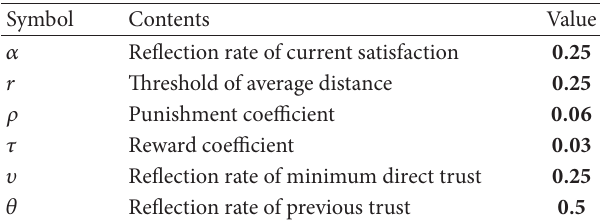
Table 5: Input variable for experiments.